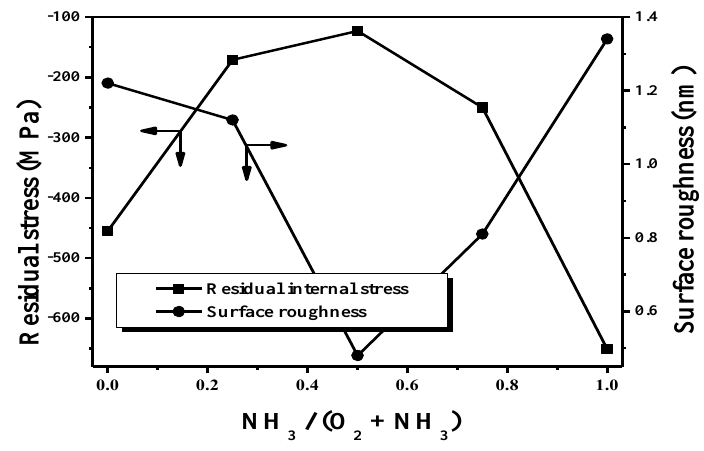
Figure 7. The relationship between the surface roughness and internal stress residing in the deposited film as a function of the gas flow ratio. Table 1. Water vapor transmission rates (WVTRs) of the films as a function of the gas flow ratio in the TMS–O 2 –NH 3 glow discharge deposited on the PET substrate, as well as their residual internal stresses and surface roughness when deposited onto the silicon substrate 1 .